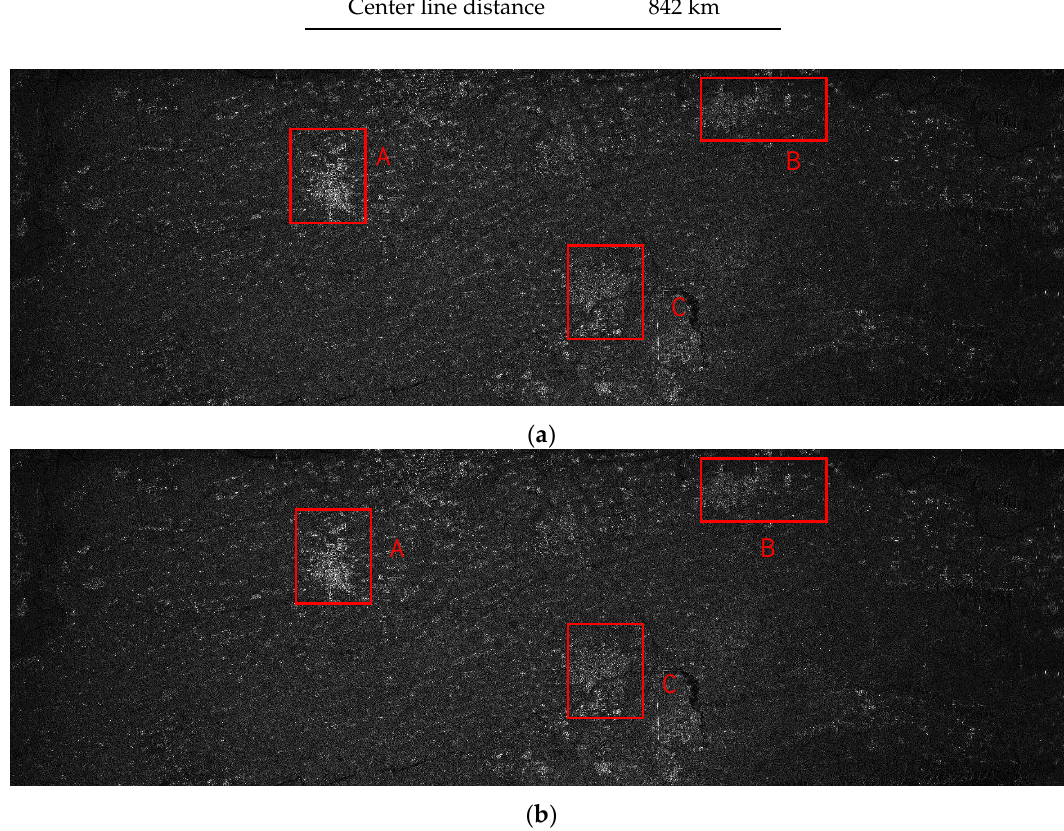
Figure 11. Imaging results of the GF3-SAR stripmap data (from top to bottom is range, and from left to right is azimuth): ( a ) standard full-aperture CSA; ( b ) proposed algorithm.